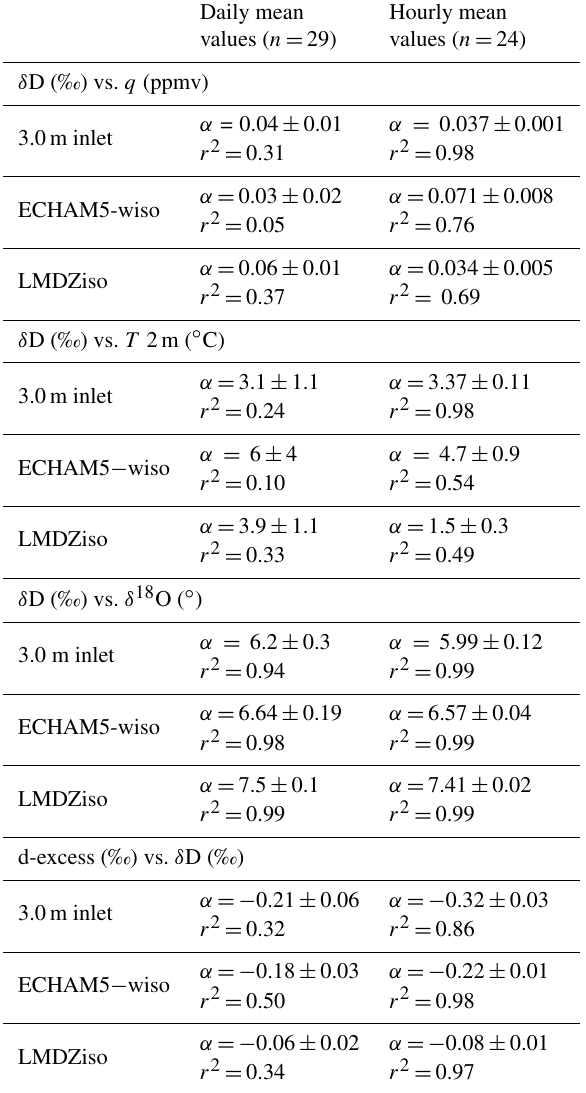
Table 5. Slopes and determination coefficients calculated from two datasets: (1) the 29 daily mean values from the campaign and (2) the 24 hourly mean values from the stack composed of 18 selected di- urnal cycles. Uncertainties represent 1SE on the